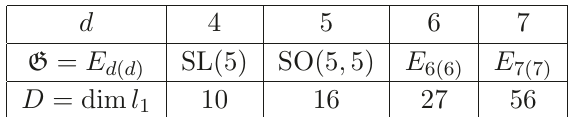
Table 1 . Duality group G for various toroidal compactification of M-theory to R 11 − d